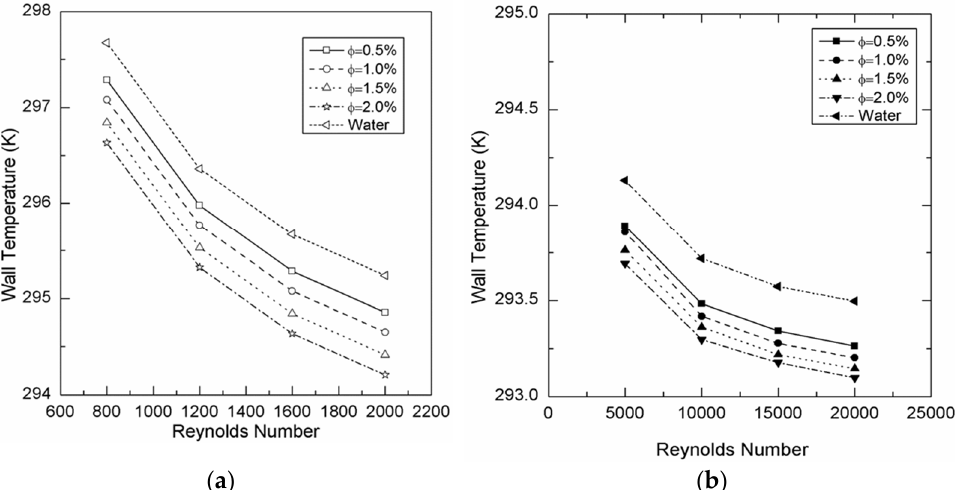
Figure 3. Variation of wall temperature with Re for Cu-water nanofluid. ( a ) Laminar condition. ( b )